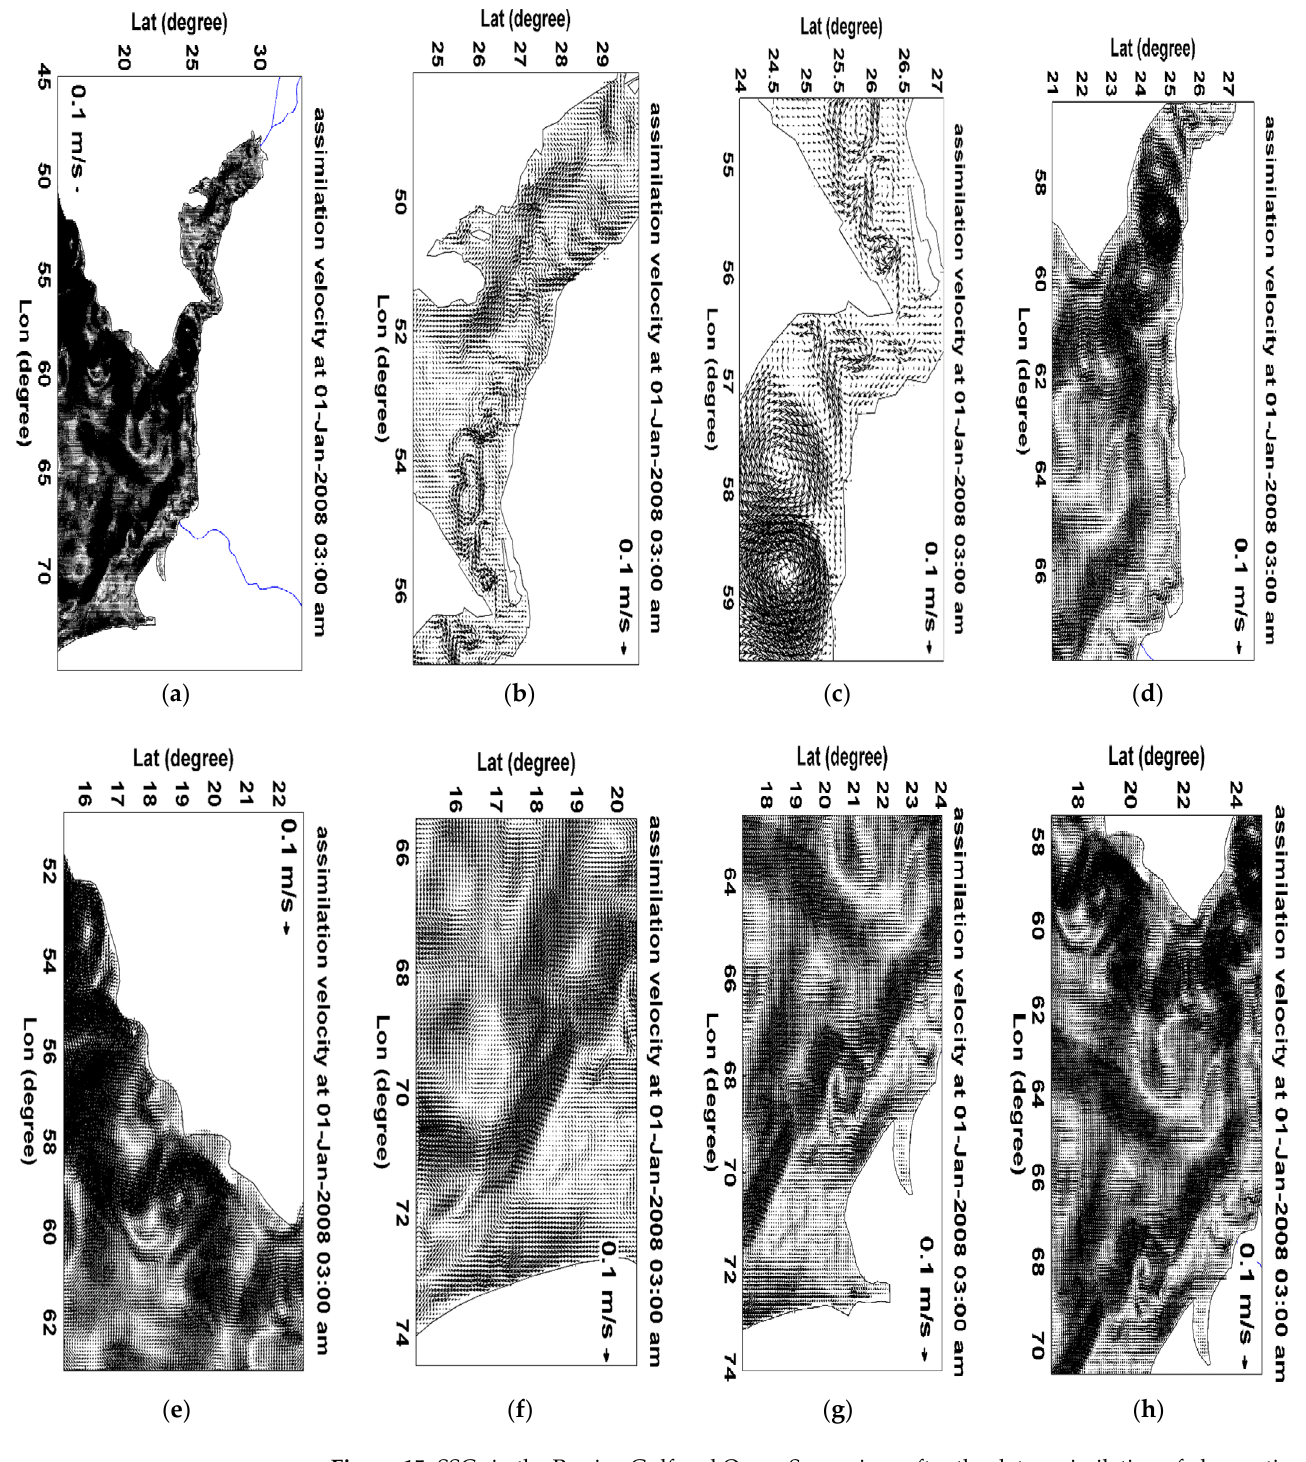
Figure 15. SSCs in the Persian Gulf and Oman Sea regions after the data assimilation of observations at 3:00 a.m. on 1 January 2008: ( a ) the whole area, ( b ) Persian Gulf, ( c ) Strait of Hormuz, ( d ) Oman Sea, ( e ) North Indian Ocean adjacent to Oman, ( f ) North Indian Ocean adjacent to India, ( g ) Oman Sea adjacent to Pakistan, and ( h ) Oman Sea and North Indian Ocean.